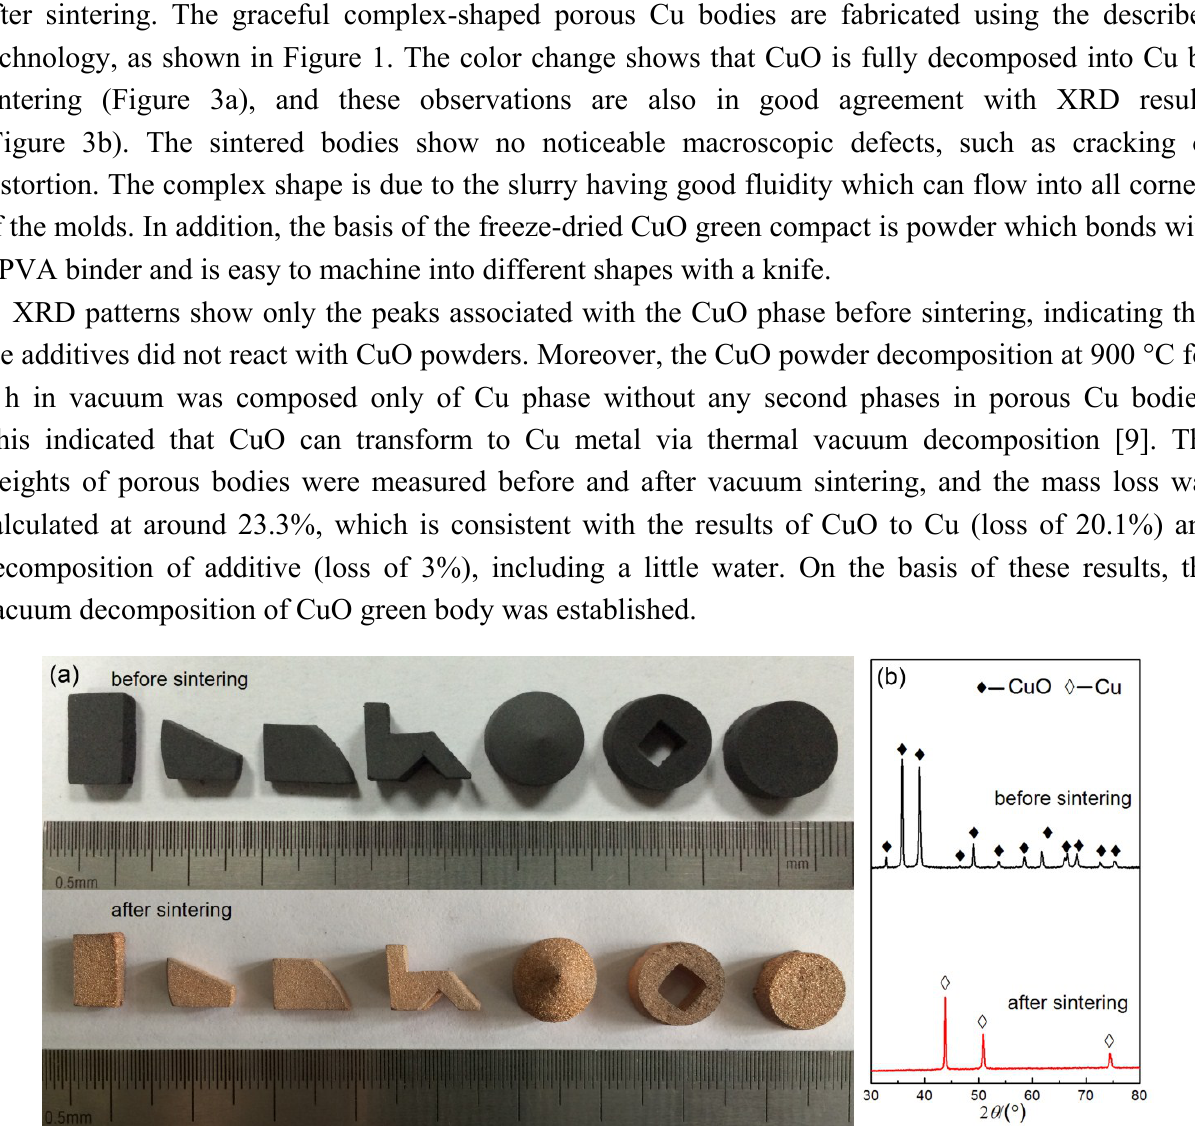
Figure 3. Macro photograph ( a ), and XRD patterns ( b ) of the porous bodies (30 vol.%) before and after vacuum